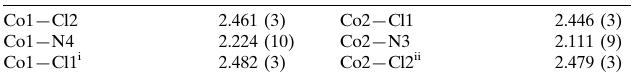
Selected bond lengths (A˚